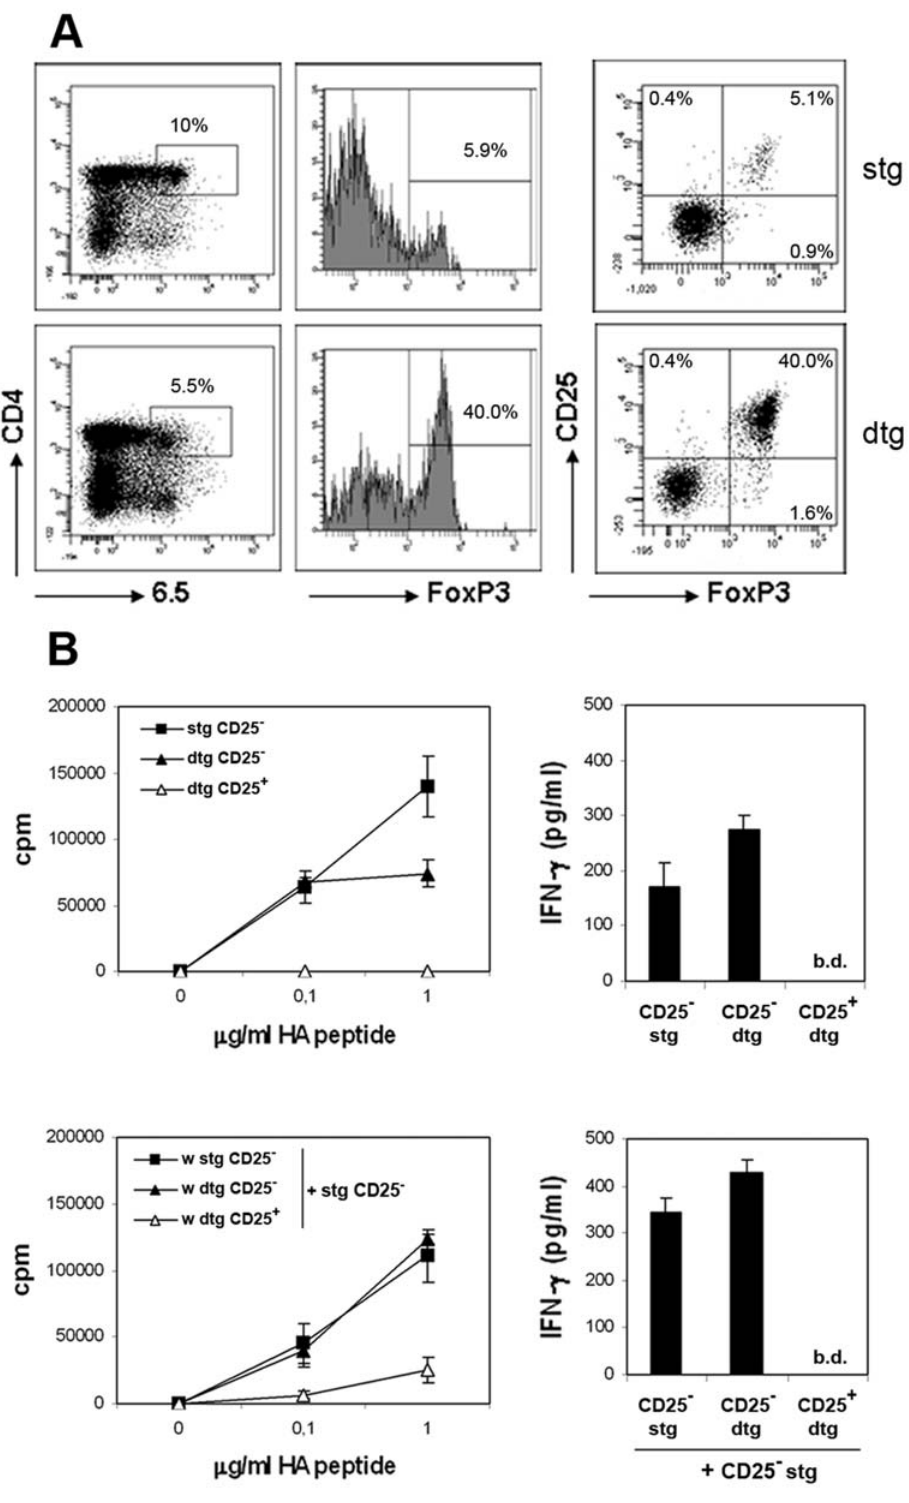
Figure 1. Tconv:Treg ratio and their proliferative capacity in stg and dtg mice. (A) Cell suspensions obtained from the LNs of stg or dtg mice were stained for CD4, 6.5, CD25 and FoxP3 and analysed by flow cytometry. Living cells were gated for CD4 and 6.5 expression. One representative dot plot is shown. (B) LN cells from stg or dtg mice were stained and sorted by flow cytometry according to CD4, CD25 and 6.5 expression. 2.5 6 10 4 sorted T cells were cultured in triplicate wells with 1.5 6 10 4 DCs and different doses of HA peptide. After 70 h of coculture, supernatants were collected for IFN c measurement and thymidine was added for an additional 16 h in order to measure proliferation (upper panels). In parallel, the ability of CD25 2 vs CD25 + dtg sorted cells to inhibit proliferation and IFN c production of naive HA-specific T cells (stg CD25 2 ) was analyzed (lower panels). Shown is one out of three independent experiments that gave similar results. b.d.=below detection.